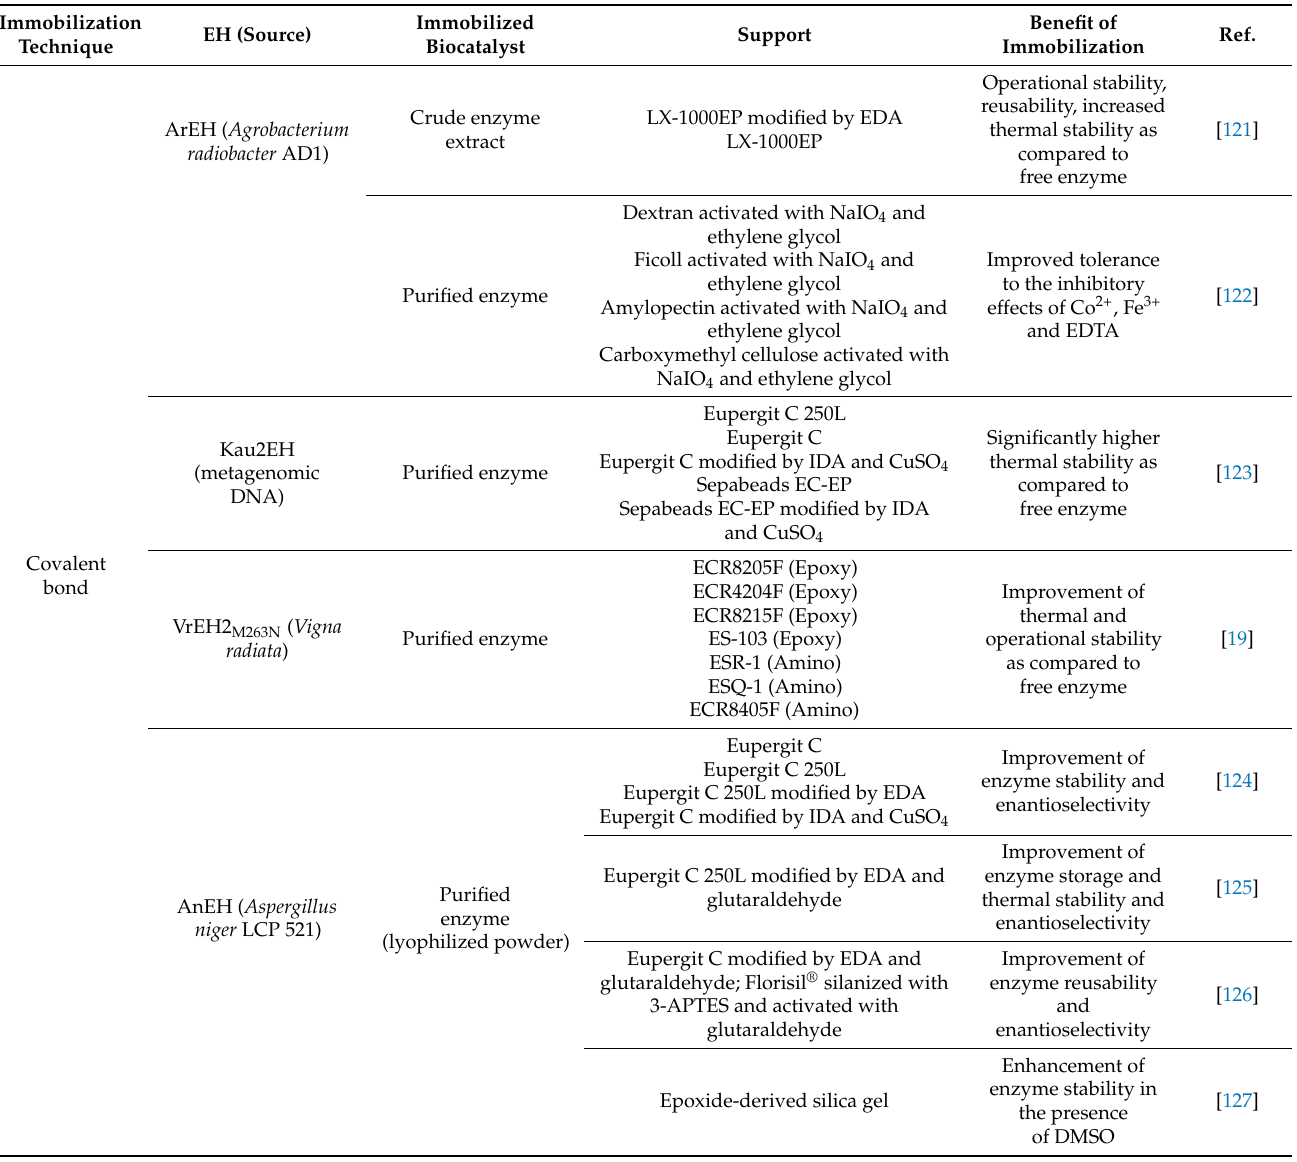
Table 3. Immobilization techniques, materials, and their benefits for